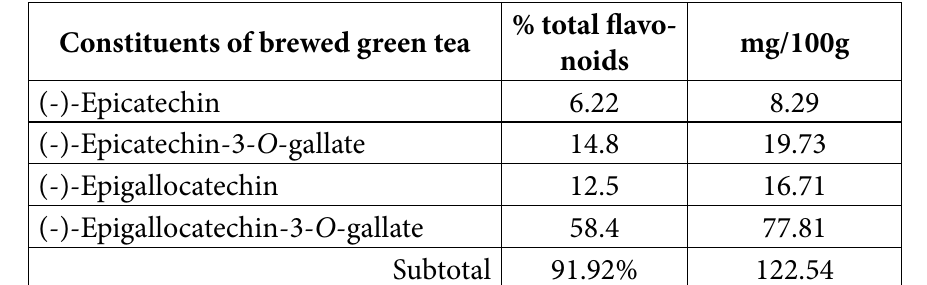
Supplementary Figure 2. Calibration curves for the compounds of interest. Supplementary Table 1. Derived from USDA